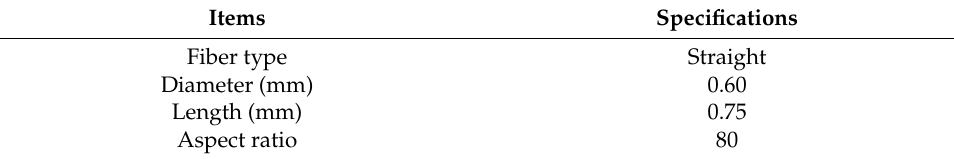
Table 3. Specifications of straight steel